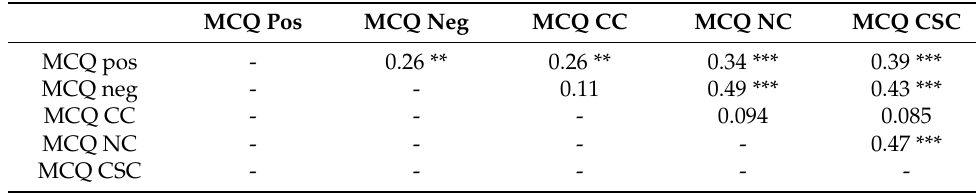
Table 2. Correlations of MCQ-30 subscales. MCQ Pos MCQ Neg MCQ CC